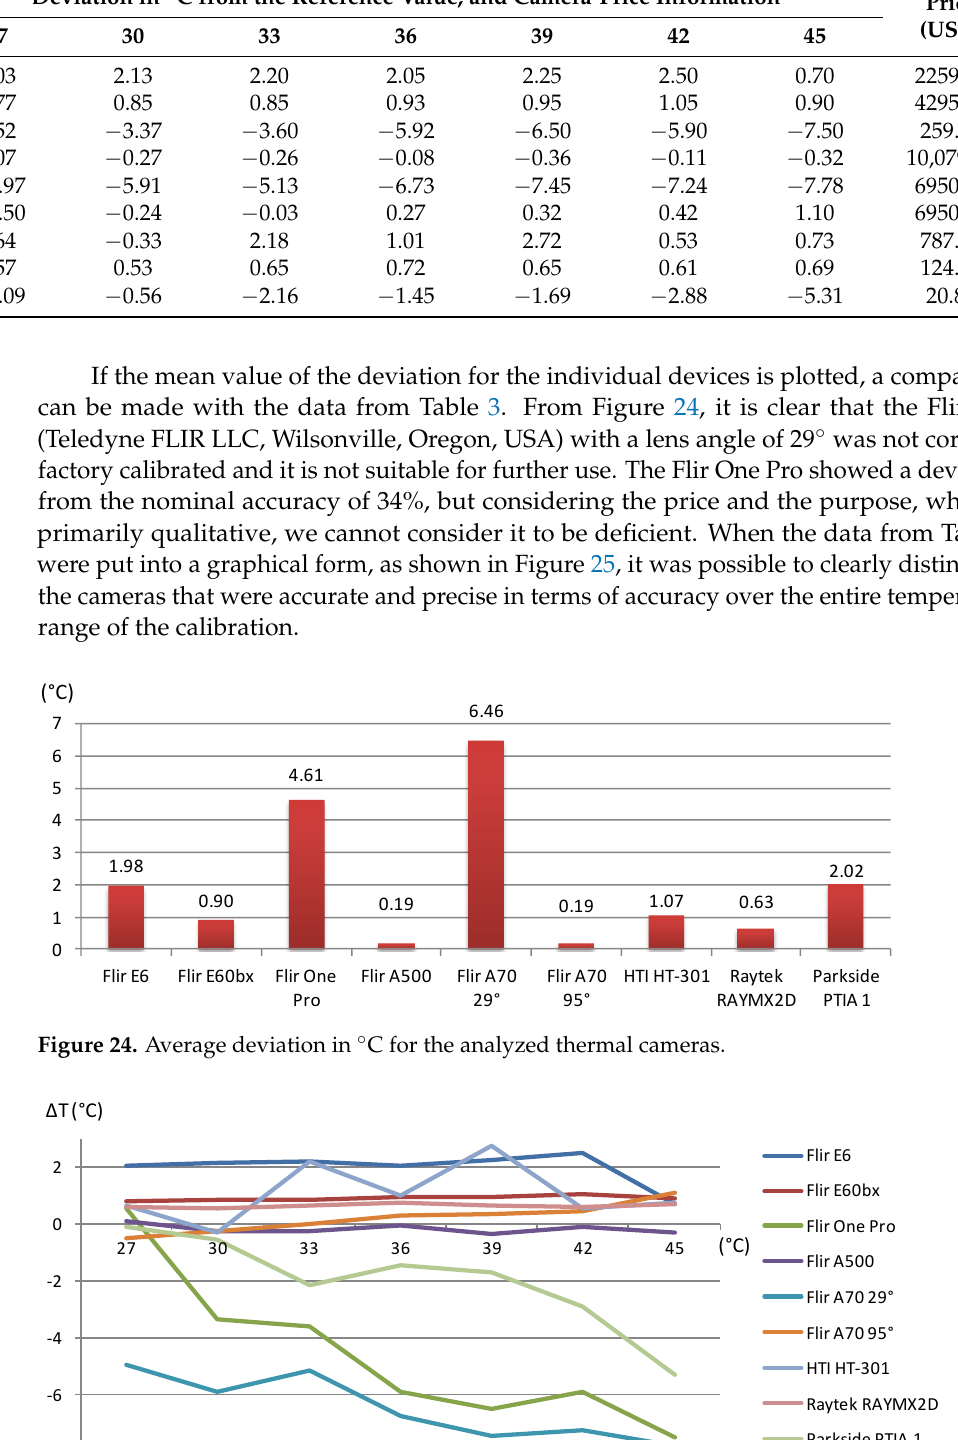
Table 6. Deviation in °C from the reference value, and camera-price information.